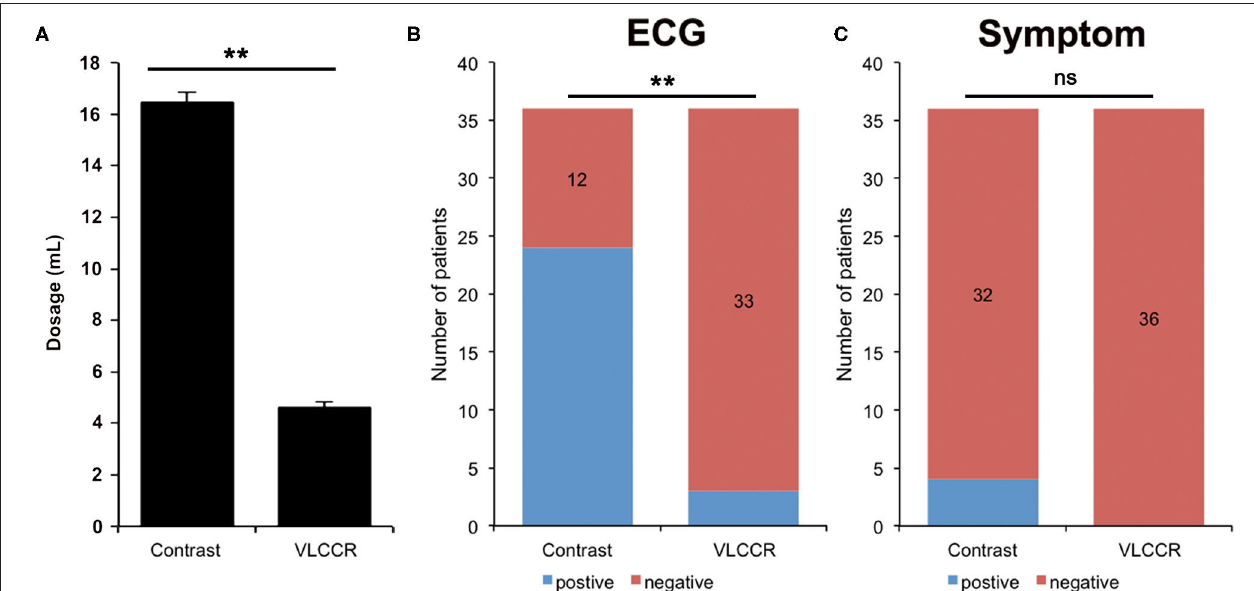
FIGURE 2 | Comparison of the amount of contrast medium and VLCCR used (A) , ECG (B) , and symptoms (C) of ACS patients ( n = 30) **P < 0.01. ns, no significant